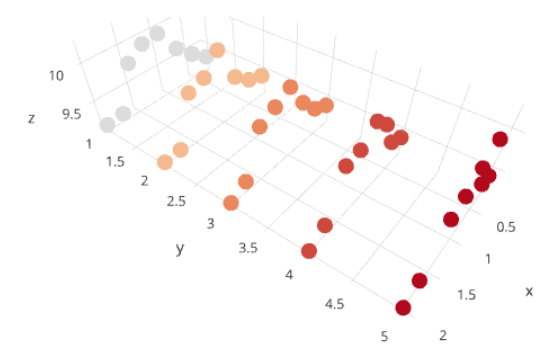
Figure 1. Graph of entropy values for spectrograms with the respect to parameters γ (on OX ), α (on OY ), and average entropy (on OZ